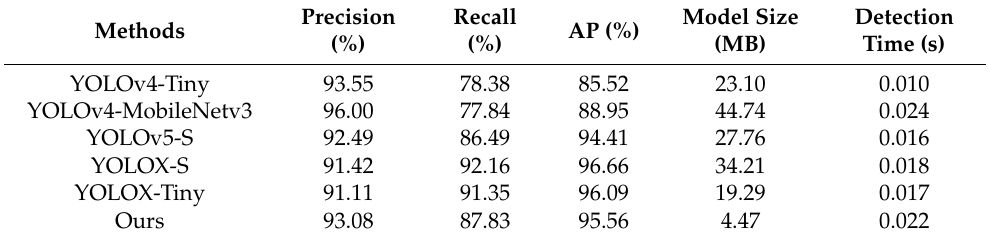
Figure 11. Size-accuracy curve for our method and other state-of-the-art object detectors.